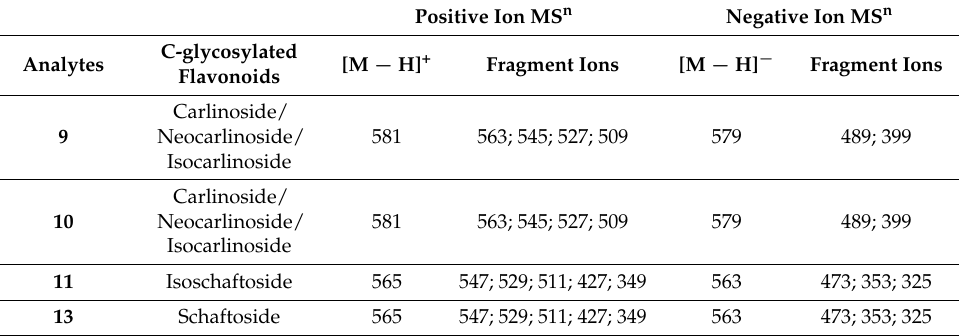
Table 1. C -glycosylated flavonoids detected in Lisosan ® G by MS n experiments.